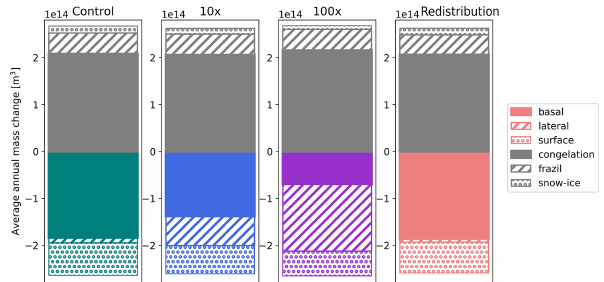
Figure 5. Annual Northern Hemisphere mass budgets for all sensi- tivity runs (from left to right: control, 10 × lateral melt, 100 × lat- eral melt, redistributed lateral melt). Grey areas represent volume of growth terms – congelation (solid), frazil (hashed), and snow–ice (dotted) – and colored areas represent volumes of melt terms – basal (solid), lateral (hashed), and surface (dotted). Results shown are av- erages over the last 5 run years for the redistributed lateral melt run and the last 25 years for all others.